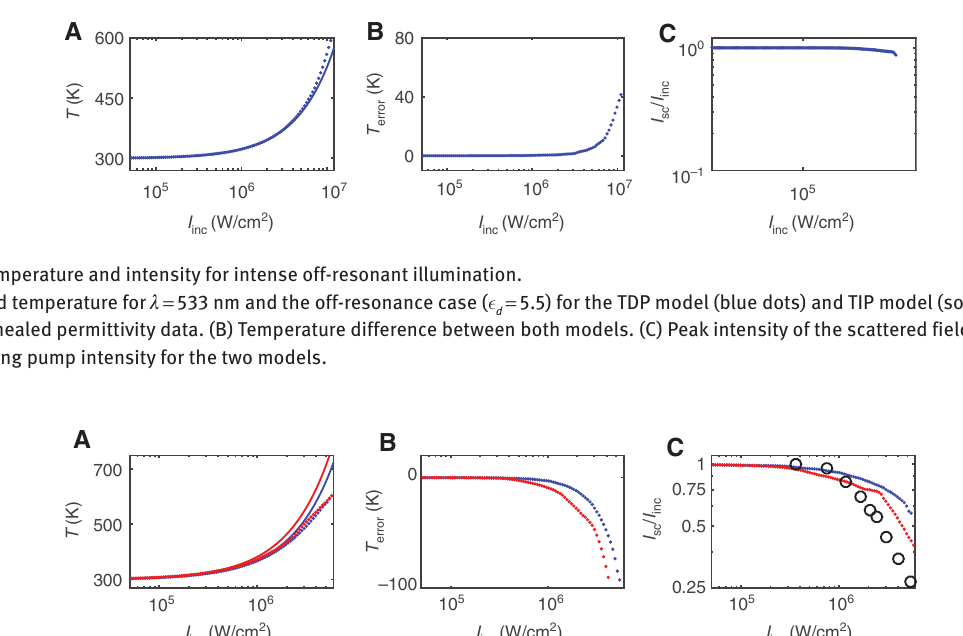
Figure 3: Temperature and intensity for intense on-resonant illumination. = 2.25). Also shown in (a) are the results for unannealed data (TDP model, Same as in Figure 2 for the on-resonance case (obtained by setting ε d red dots; TIP model, solid red line), and (b) shows the corresponding difference between the two models. Finally, (c) shows also the ( normalized) experimentally measured data of scattering from a single 40 nm Au NP embedded in index matching oil under CW